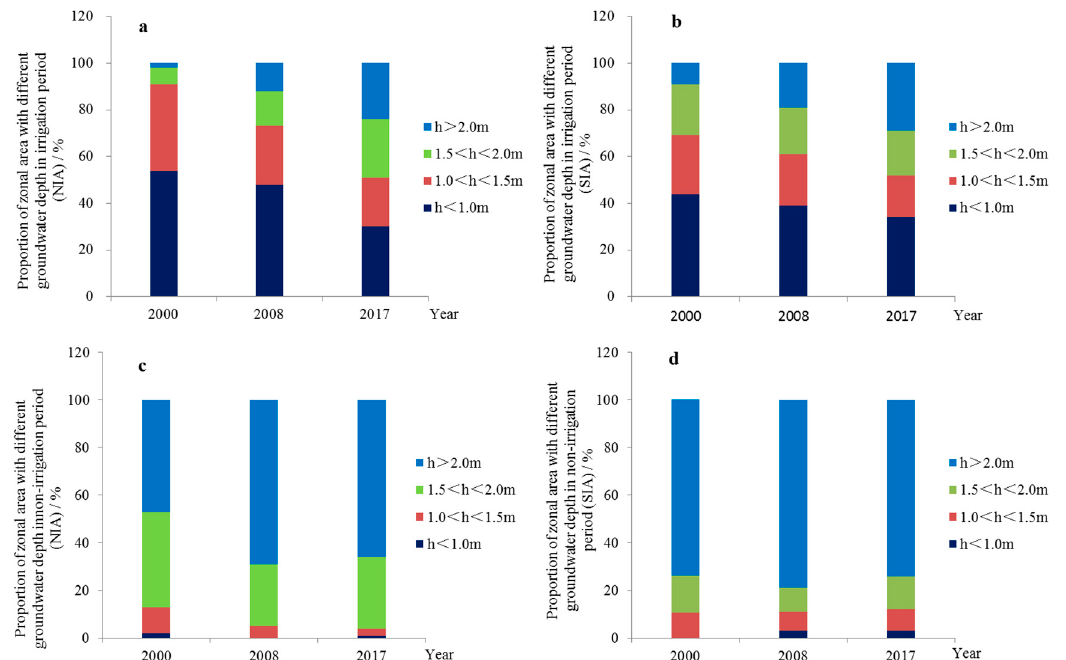
Figure 4. Proportion of zonal area with di ff erent groundwater depths: ( a , b ) Proportion of zonal area with di ff erent groundwater depths in the irrigation period, ( c , d ) proportion of zonal area with di ff erent groundwater depths in the non-irrigation period. NIA: Northern Irrigation Area; SIA: Southern Irrigation Area.